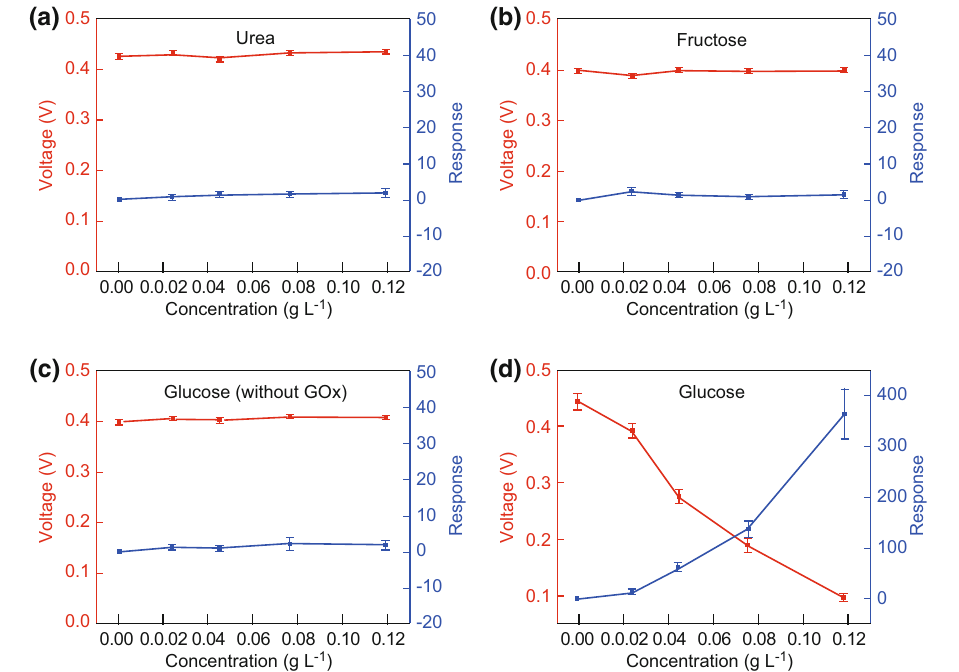
Fig. 4 a , b The outputting piezoelectric voltage and response of the self-powered implantable skin-like glucometer against urea and fructose. c The outputting piezoelectric voltage and response of the device without GOx modification against glucose. d The outputting piezoelectric voltage and response of the device with GOx modification against 0.11 V, respectively. The enlarged views of the outputting piezoelectric voltage against 0.024, 0.045, and 0.076 g L - 1 are shown in Fig. 3c. These results indicate that the device can monitor the glucose concentration [47, 48].